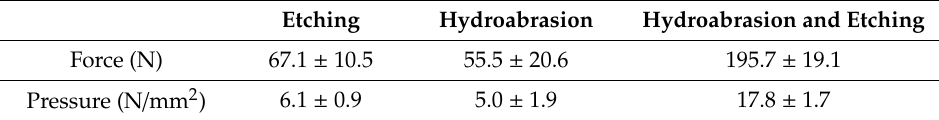
Table 1. Descriptive statistics for debonding force and pressure ( n = 10).